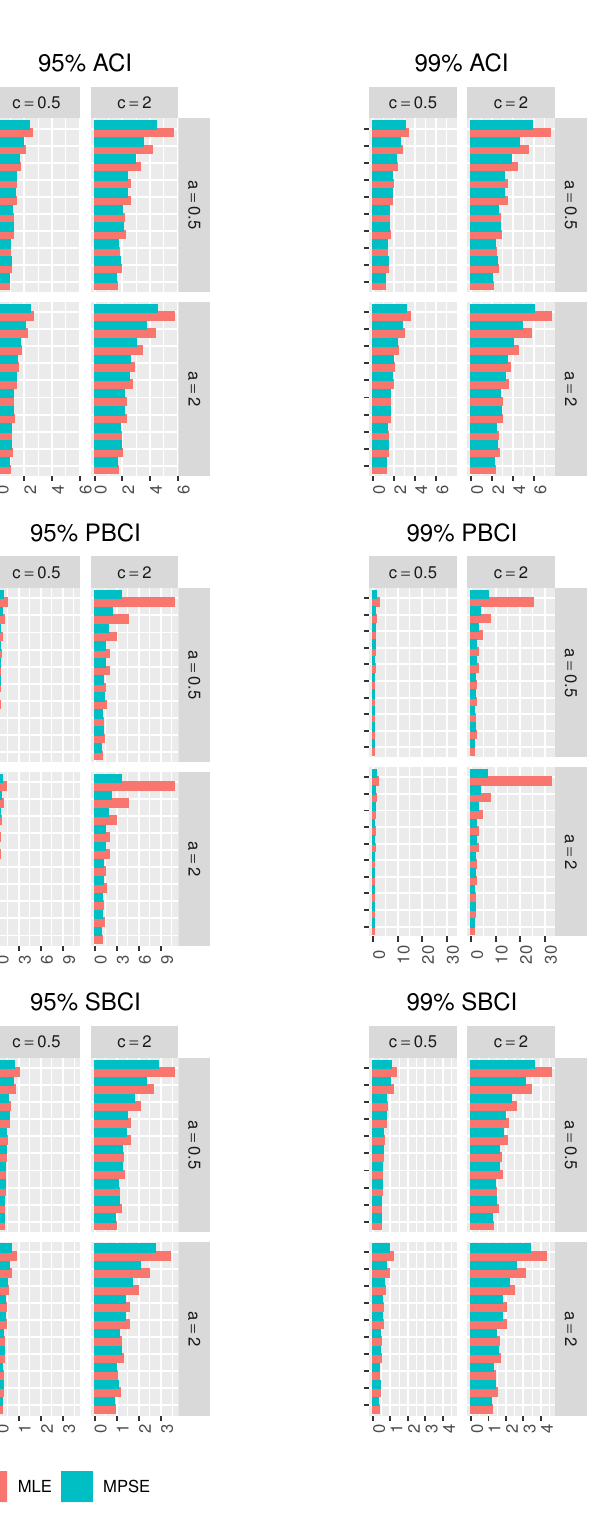
Figure 7. Simulated Lens of different CIs of c